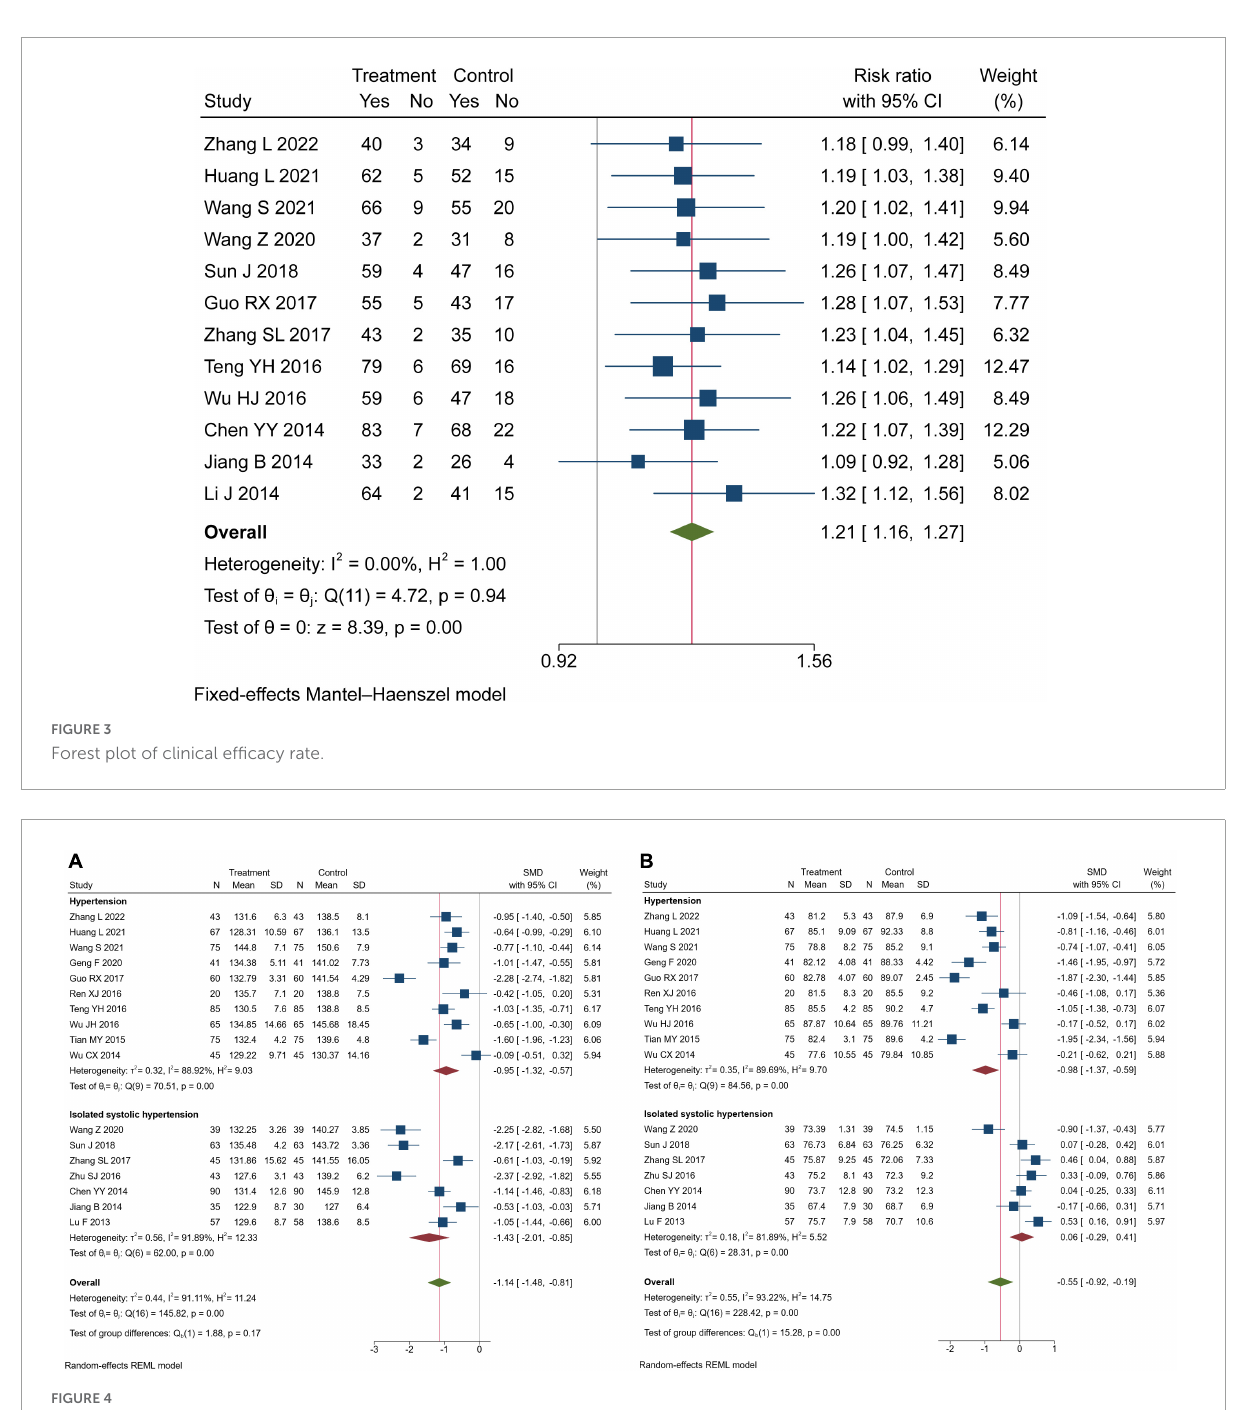
was caused by the different measurement methods and units of NO and